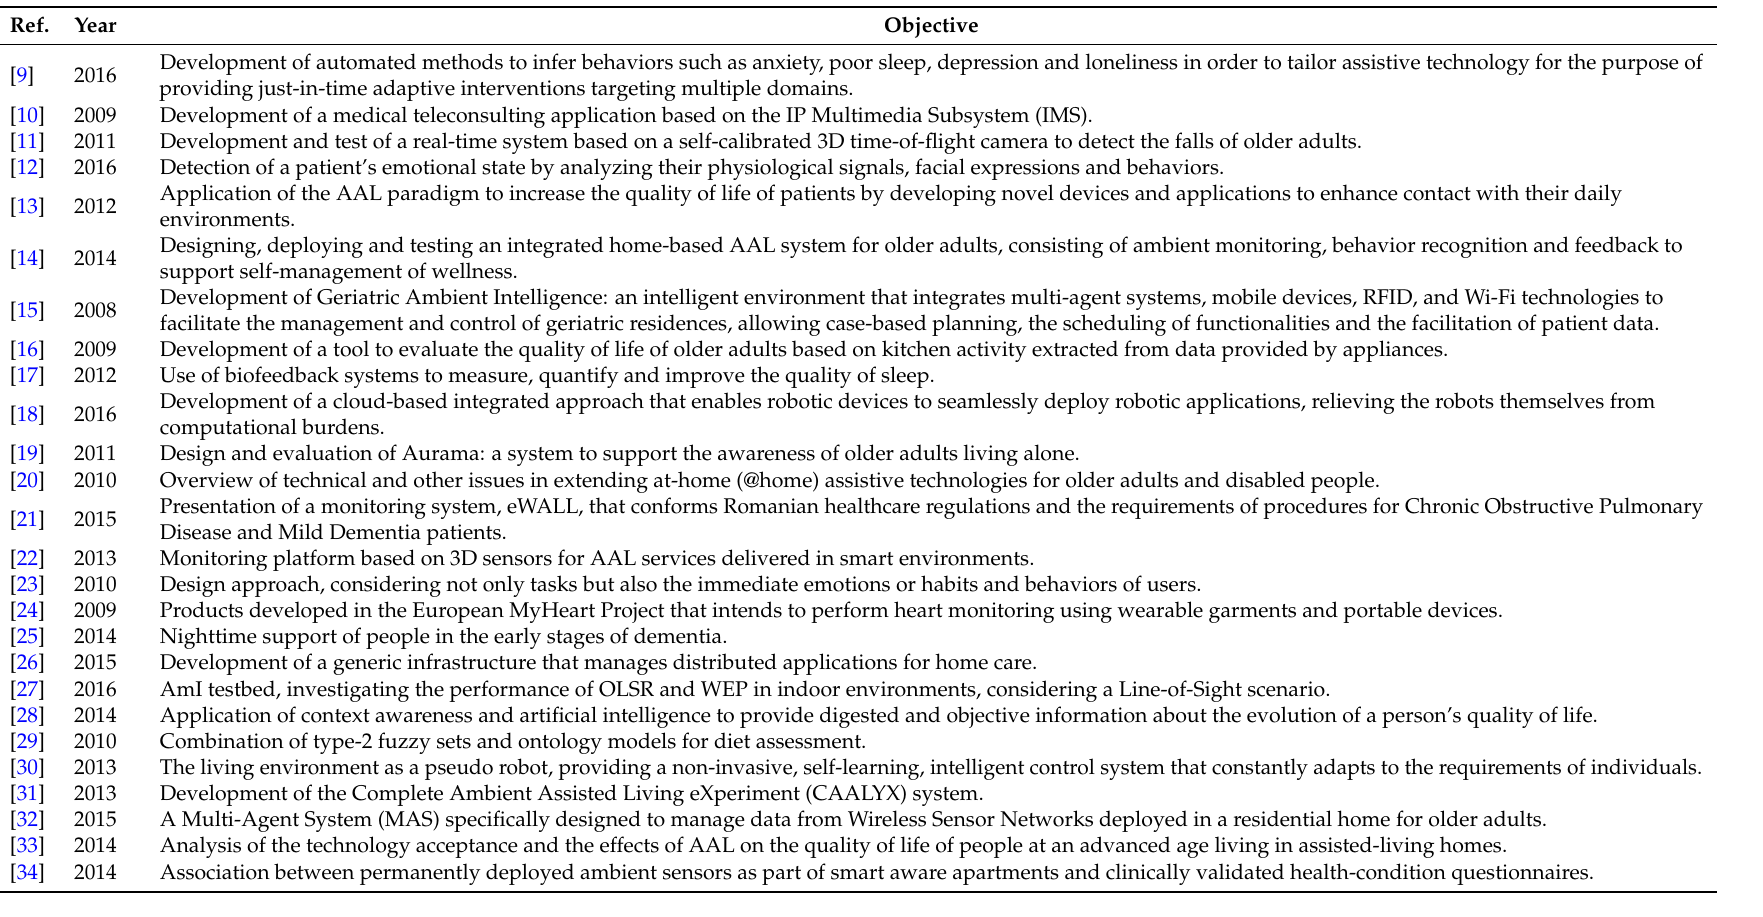
Table 1. Scope of the selected